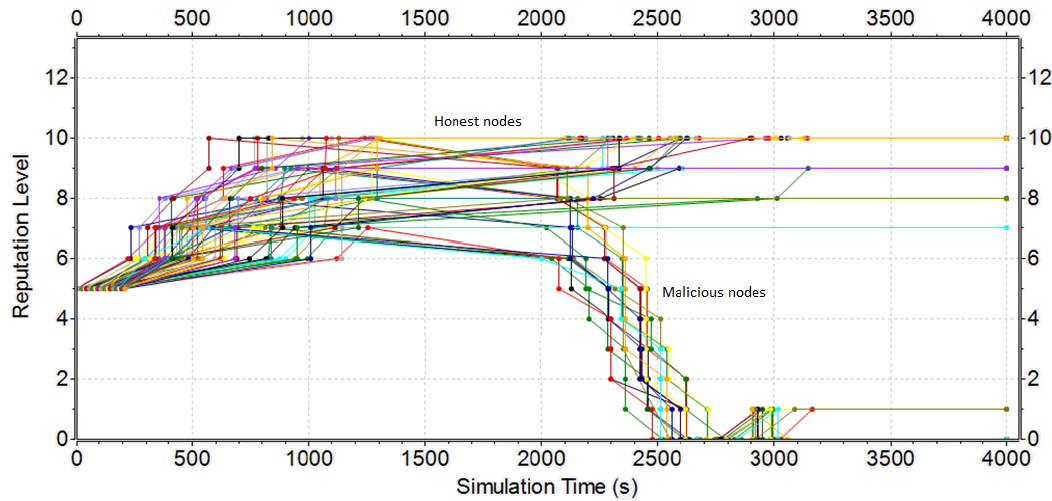
Figure 15. Reputation Evolution for Inconsistency attack—Manhattan-Grid Scenario.